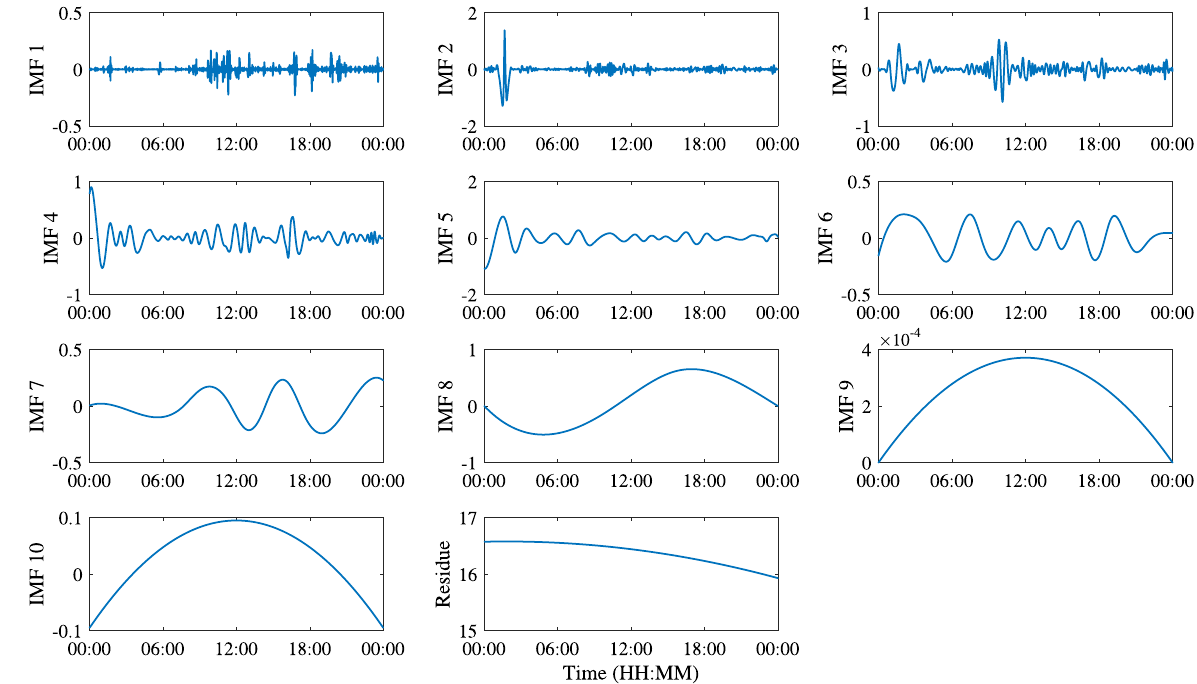
Figure 7. The IMFs and residue of EEMD of temperature at a depth of 155 m on July 29,